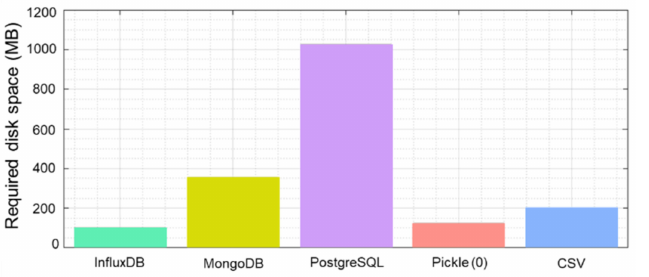
Figure 14. Required disk space for the different storage types for a dataset with 10 6 data points plus time stamp. InfluxDB shows the highest compression rate for those kinds of